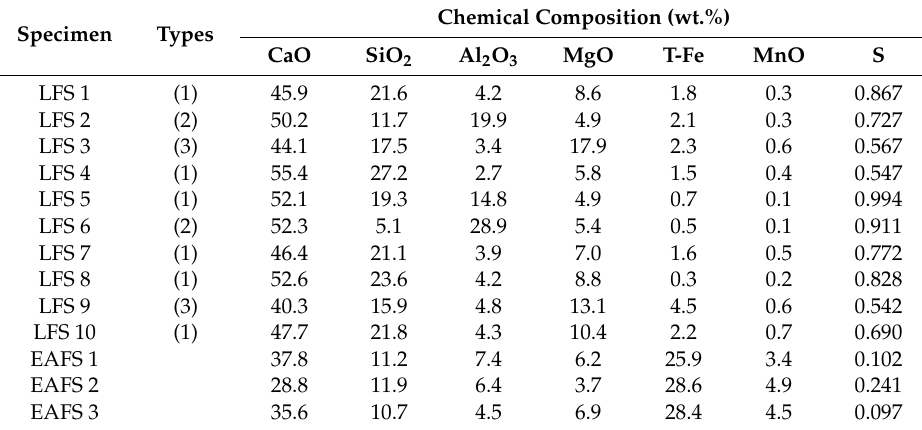
Table 1. Compositions of LFS and EAFS as determined by WDXRF spectroscopy. Types of LFS: (1) a